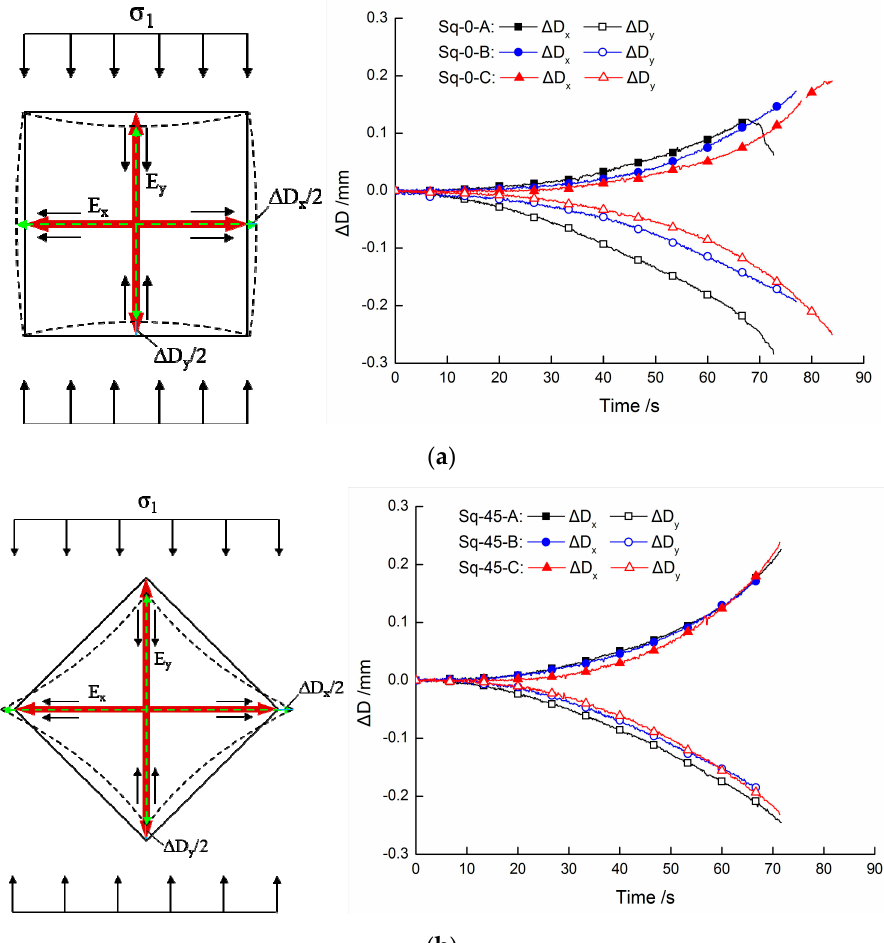
Figure 7. Layout of virtual extensometers around 0° ( a ) and 45° ( b ) square hole and the variation in hole apertures with filling mode.